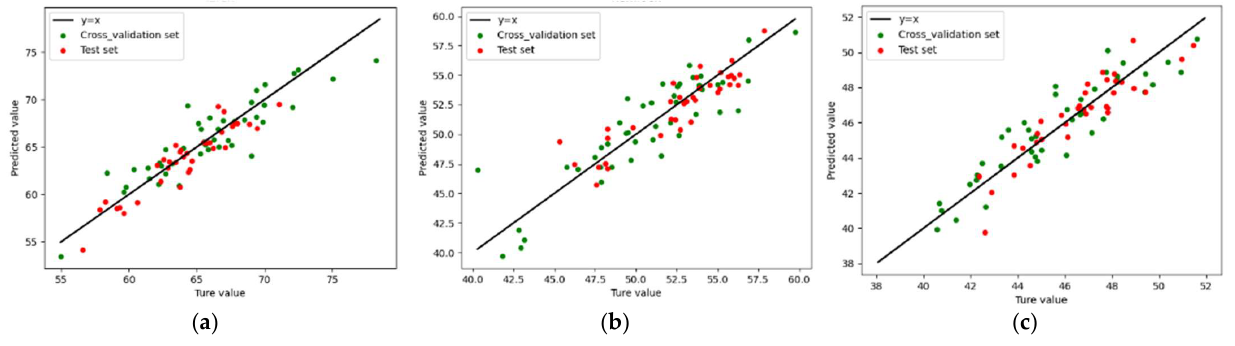
Figure 17. SE-DenseNet for three coniferous wood’s mechanical strength regression: ( a ) Cross validation and prediction results for larch; ( b ) Cross validation and prediction results for hemlock; ( c ) Cross validation and prediction results for mongolica. Table 8. Comparison of results of numerical regression methods.